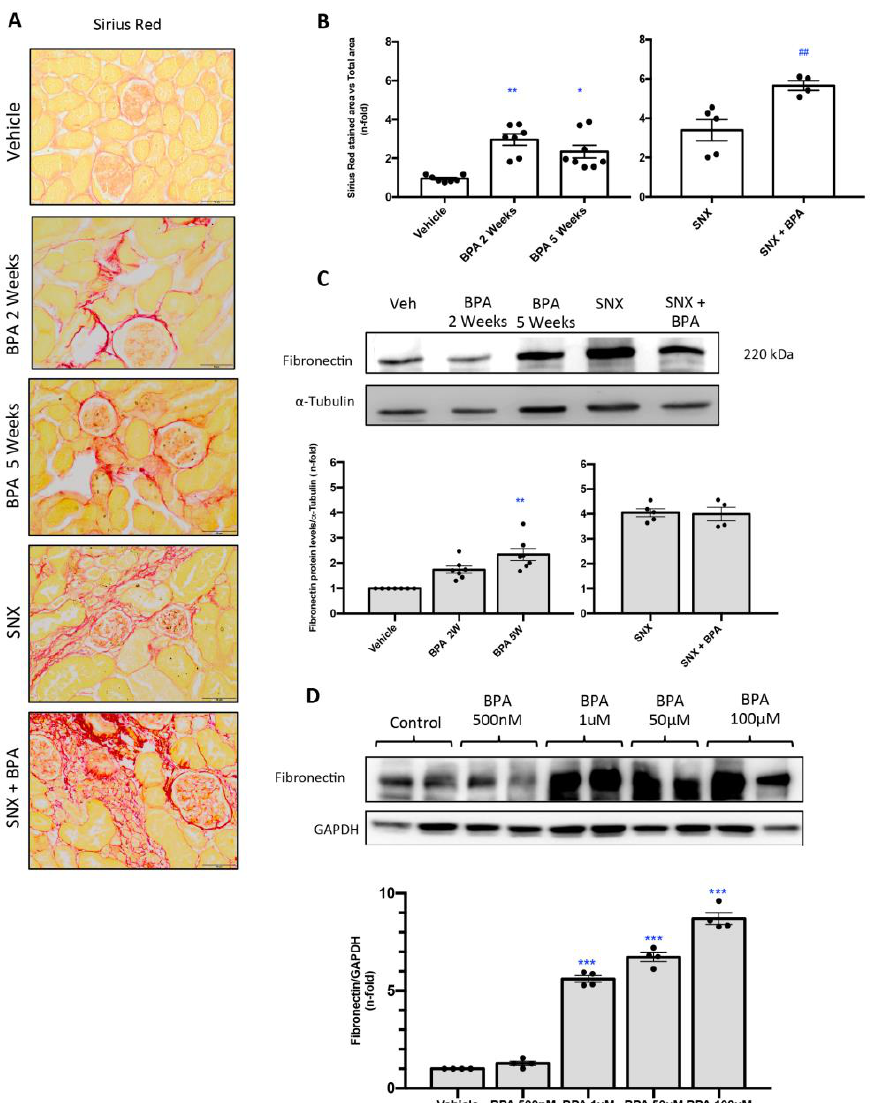
Figure 4. Systemic chronic administration of BPA induces renal fibrosis in mice . Animals were intraperitoneal injected with 120 mg/kg/day BPA (5 days a week) or vehicle (corn oil) and sacrificed after 2 or 5 weeks. Some animals were subjected to subtotal nephrectomy (SNX), then treated or not with BPA and sacrificed after 5 weeks. ( A , B ) Collagen deposition was evaluated in paraffin-embedded sections by Sirius Red staining; quantification assessed the stained area vs. total area. ( A ) Figures show a representative picture from each group. Magnification 200 X. (scale bar appears in lower right area of the image and represents 50 µm). ( B ) The quantification of Sirius Red staining. ( C ) Fibronectin protein levels were evalu- ated in total renal extracts by Western blot. Figures shows representative mice from each group and the quantification of the Western blot data. Data are expressed as mean ± SEM of 4 – 7 animals per group. * p < 0.05 vs. control; *** p < 0.001 vs. control; ## p < 0.01 vs. SNX. ( D ) Treatment with BPA increases ECM proteins production in cultured renal cells. HK2 c ells were treated with BPA at dose of 500 nM, 1, 50 and 100 μM for 48 h. Fibronectin levels were detected by Western blot. Figures shows representative experiment and the quantification of the Western blot. All data are presented as the mean ± SEM of 4 experiments, * p < 0.05; ** p <0.01; *** p < 0.001 vs. Vehicle, ## p < 0.01; vs. BPA. Comparison between SNX vs. SNX + BPA groups was performed using a parametric unpaired two-sided T test. The analysis of WT vs. BPA-treated groups was done by one-way ANOVA, followed by the Tukey HSD multiple comparison Test.